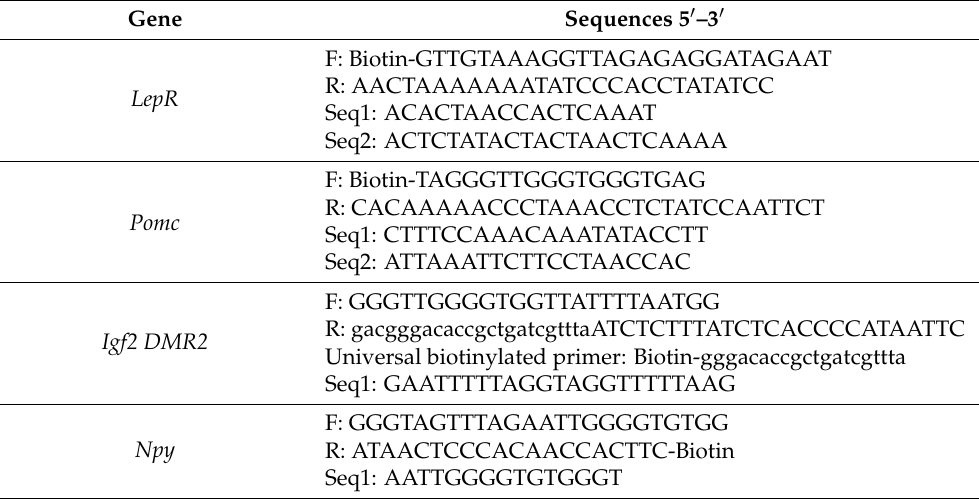
Table 1. Sequence of primers used in the methylation